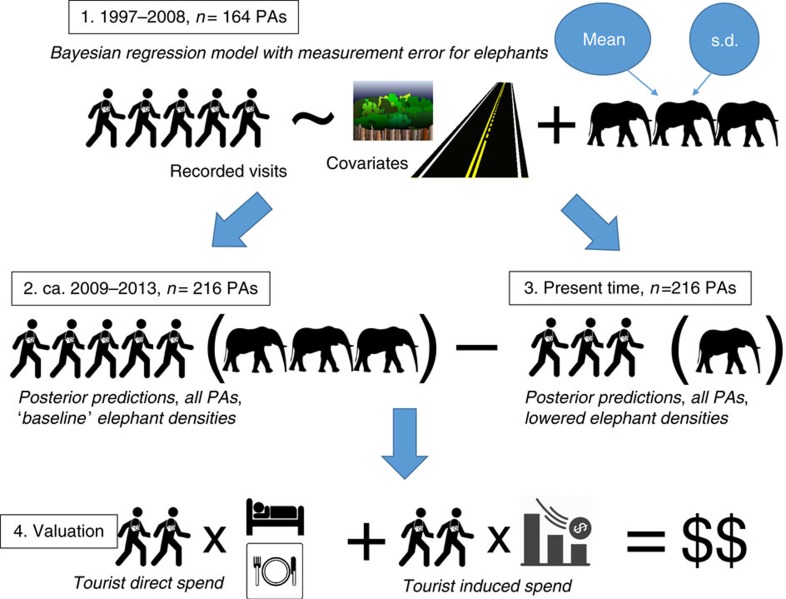
Workflow representation of methods.Our modelling methodology involved the following steps: (1) Bayesian model estimation of tourist visits at 164 PAs; (2) predicted visits at 216 PAs, no elephant poaching; (3) predicted visits at 216 PAs, with reduced elephant densities from poaching; (4) stochastic valuation of lost visits via distributions of the direct and indirect spending of tourists at PAs.